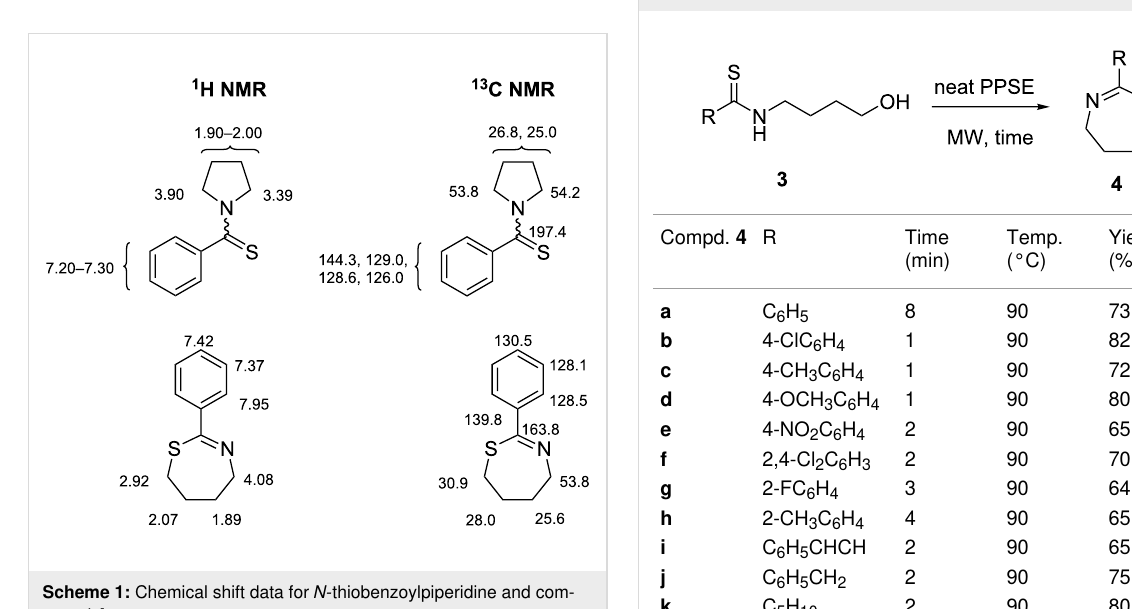
Table 2: Synthesis of 4,5,6,7-tetrahydrothiazepines 4